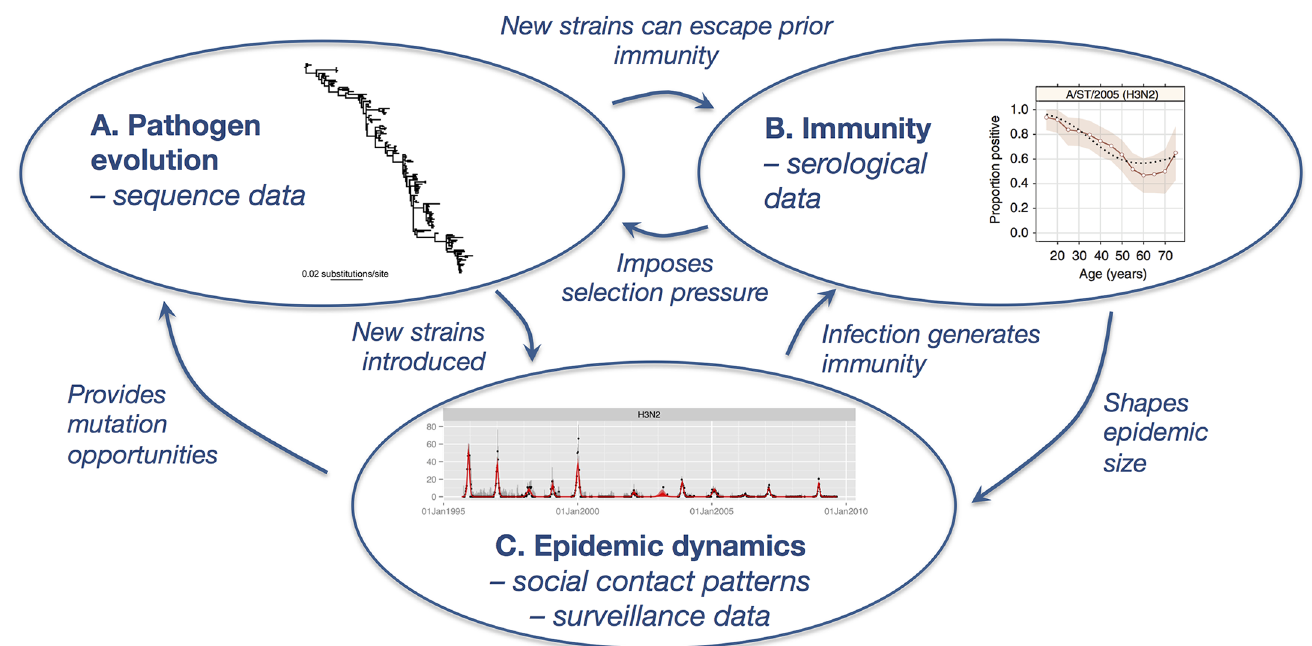
Fig 1. Influenza immunological, epidemiological, and evolutionary dynamics. Influenzaundergoesantigenic evolutionover time, escapingprior immunity and generatingnew epidemics. These epidemics can in turn give rise to new strains. To fully understand the dynamics of such infections, it is therefore important to consider the interactions betweenthese 3 processes. Illustrative figures shown for influenzaA/H3N2: (A) globalphylogeny [25], (B) proportionof individuals with detectabletiters in China [26], and (C) clinicalreports in the United Kingdom[14].